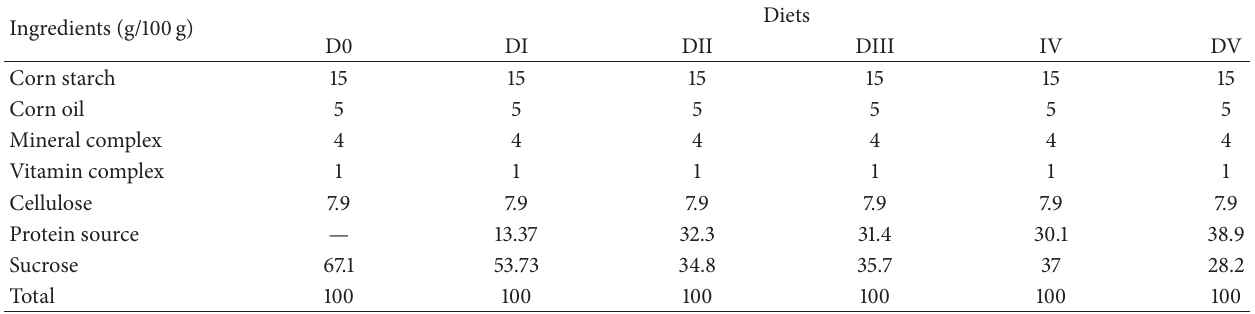
Table 1: Ingredient and composition of